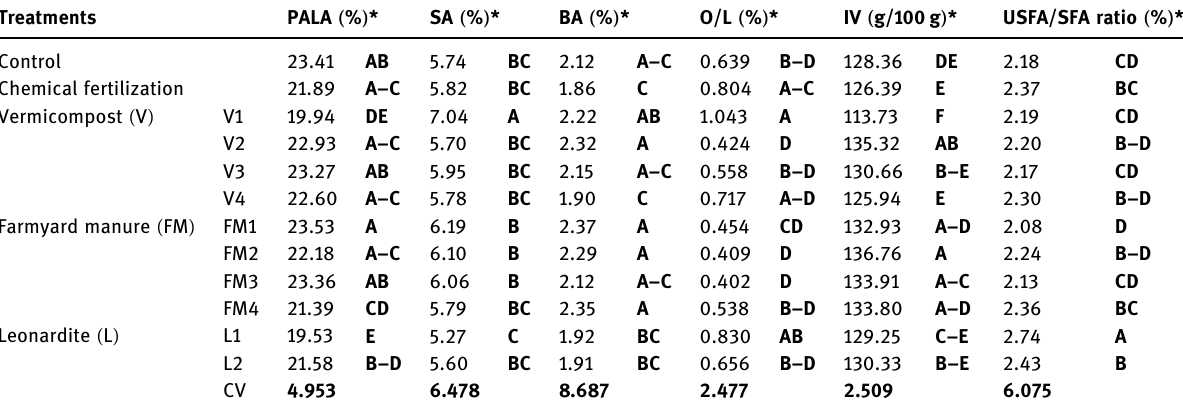
Table 4: E ff ects of di ff erent fertilizer forms on observed oil acid composition of cowpea